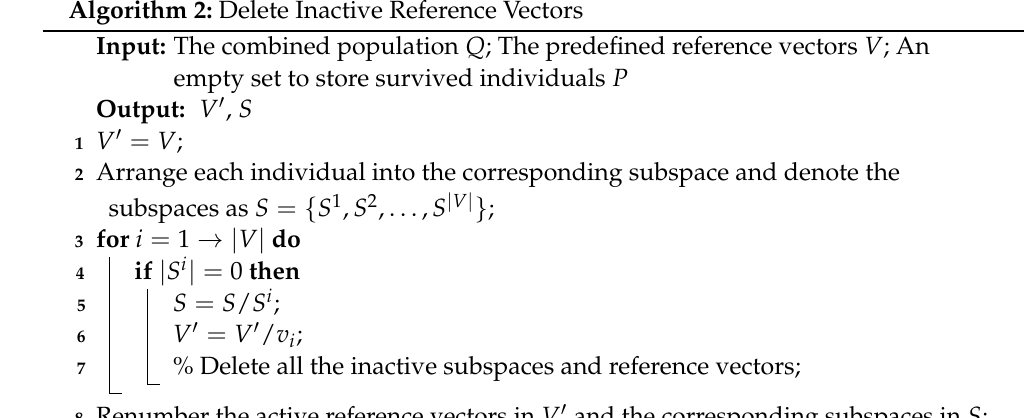
Algorithm 2: Delete Inactive Reference Vectors